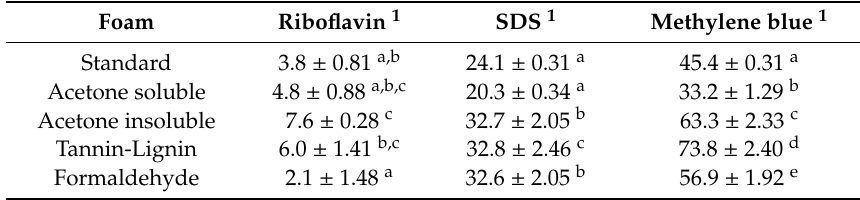
Table 2. Adsorption capacities [mg / g] of the foams against di ff erent pollutants.